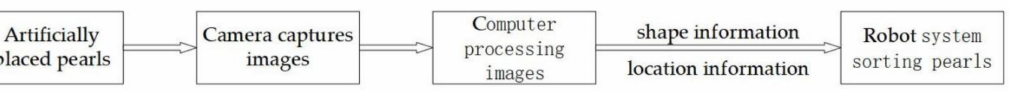
Figure 2. Operation